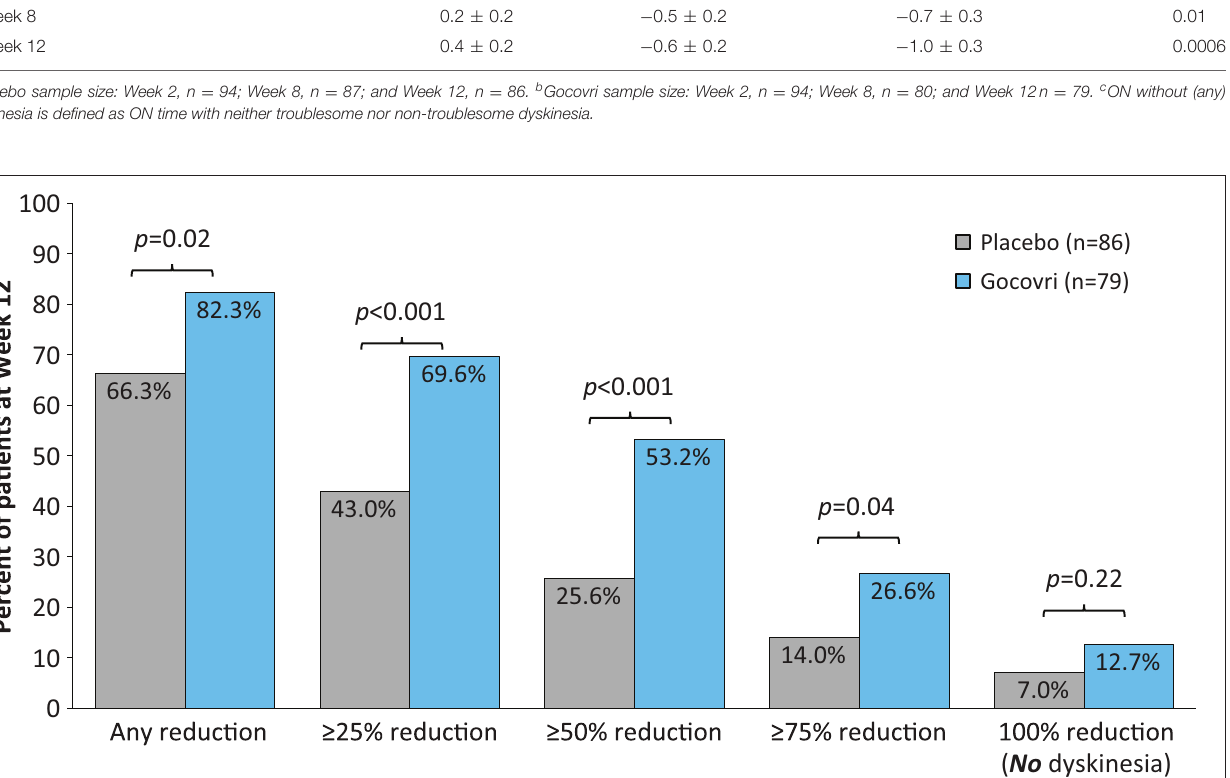
Likewise, the proportion of Gocovri-treated patients spending ≥ 50% of their waking day ON without dyskinesia rose from 5 to 56% at Week 12—compared with a corresponding increase from 6% to 23% in the placebo group ( Figure 3B